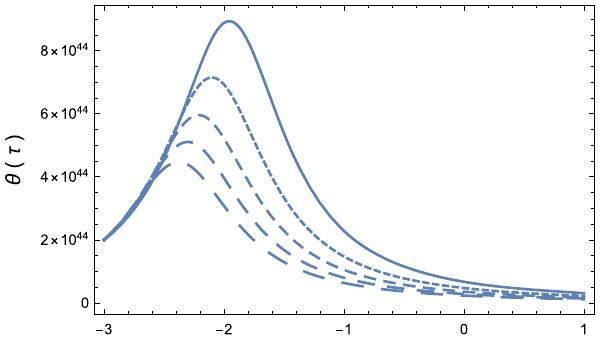
Fig. 6 Time evolution of the scale factor a (left figure) and of the dimensionless Hubble function h (right figure) in a loop quantum cos- mologicalUniversefilledwithadeformedphotongassatisfyingthedis- (cid:2) persion relation E = kc 1 − 2 β k 2 , for different values of the param- eter A 3 : A 3 = 4 × 10 − 44 (solid curve), A 3 = 5 × 10 − 44 (dotted